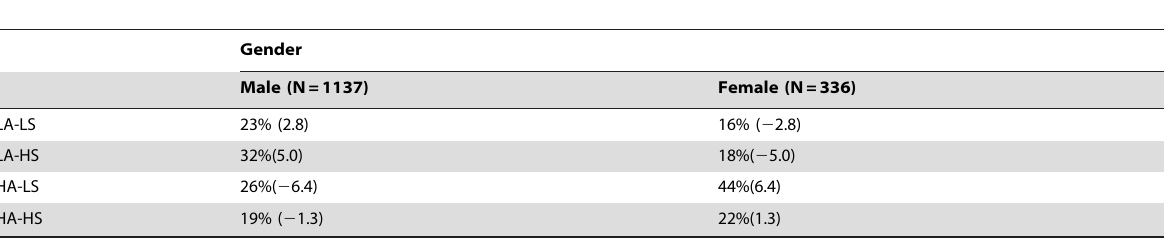
Table 5. Gender-specific Percent Distribution over the four